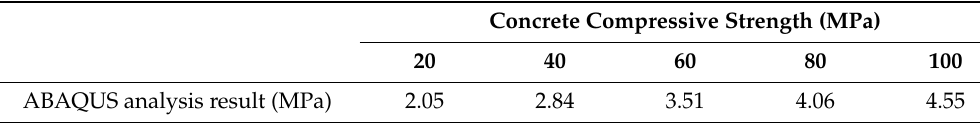
Table 7. ABAQUS analysis result of strut-and-tie method.